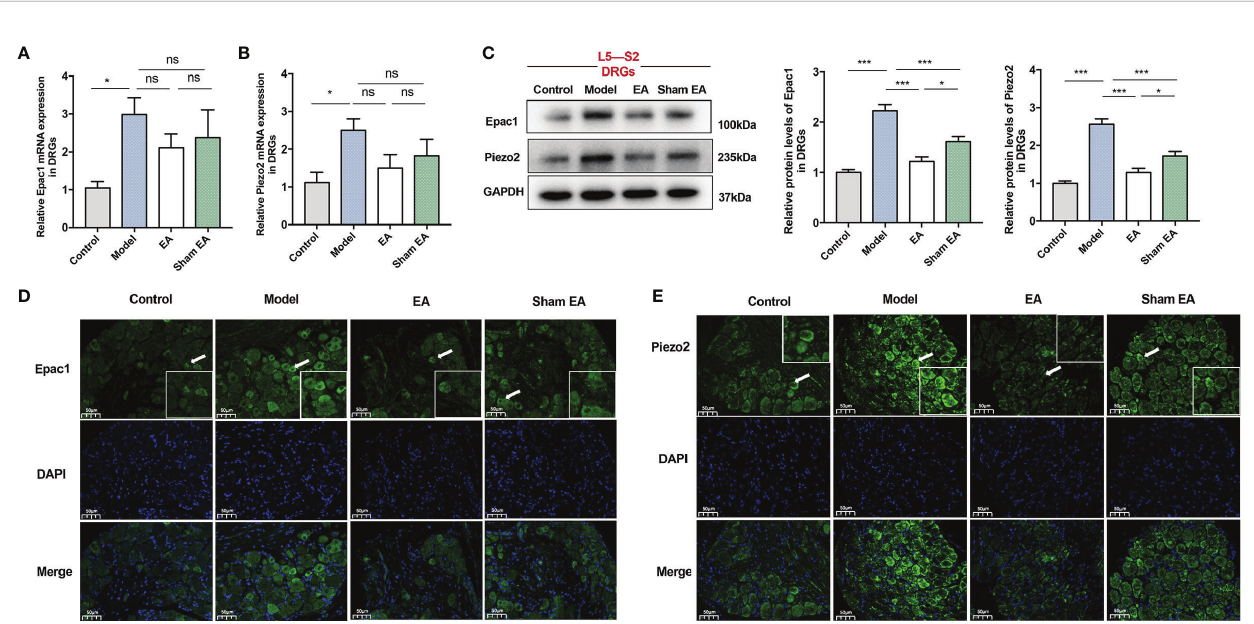
FIGURE 4 | Effect of EA on the expression of Epac1 and Piezo2 in the L5-S2 dorsal root ganglia of PI-IBS model mice. (A) Relative Epac1 mRNA and (B) Piezo2 mRNA expressions in the dorsal root ganglia. (C) Representative Western blot analyses of Epac1 and Piezo2 staining and relative protein levels in the dorsal root ganglia. (D, E) Representative images of immuno fl uorescence labeling of Epac1 and Piezo2 (×400, scale bar=50 m m). Arrowheads indicate Epac1 or Piezo2 positive cells. Boxes represent the local magni fi cation of positive cells. Data are presented as mean ± SEM; (A-C) : One-way ANOVA with LSD multiple comparisons test; n = 5 per group, * P < 0.05, *** P < 0.001, ns P